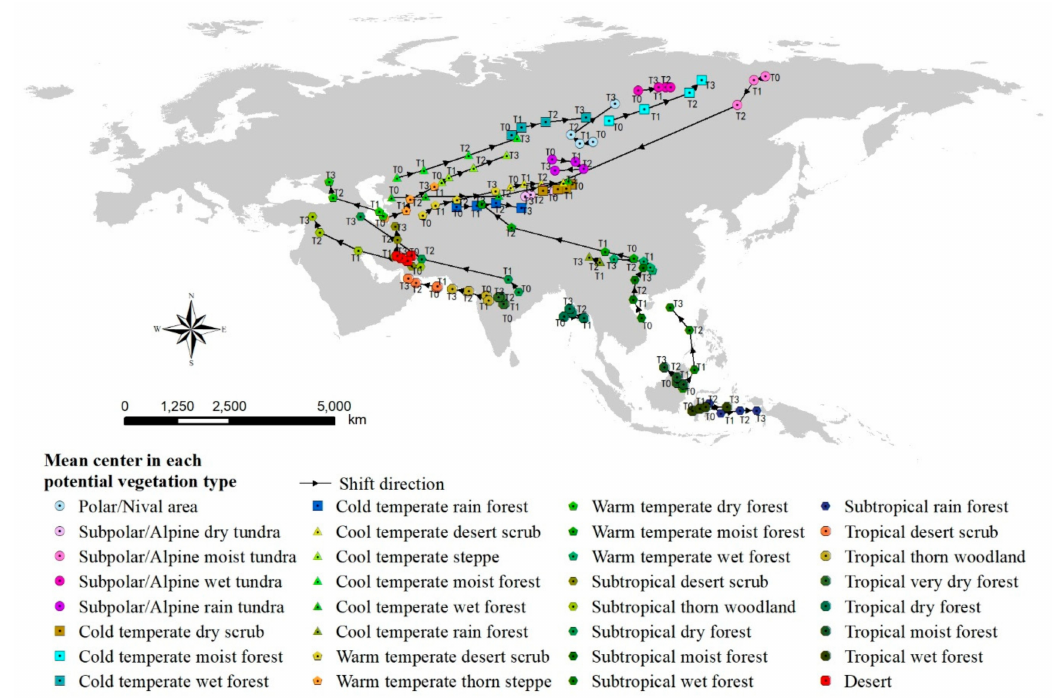
Figure 5. Shift trends of the mean centers of each potential vegetation type under the RCP8.5 scenario in